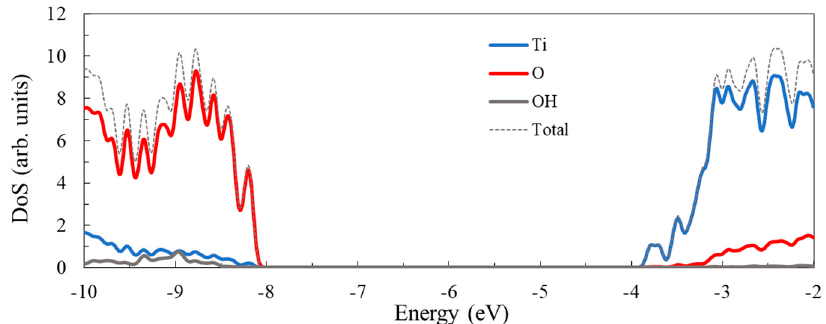
Figure 6. Total density of states (DoS) of the Ti 54 O 110 H 4 cluster, calculated at the DFT/B3LYP/LANL2DZ level in water, showing, separately, the contribution of Ti atoms, O atoms, and –OH groups. Energy levels were convoluted with Gaussian distributions with an FWHM of 0.1 eV.